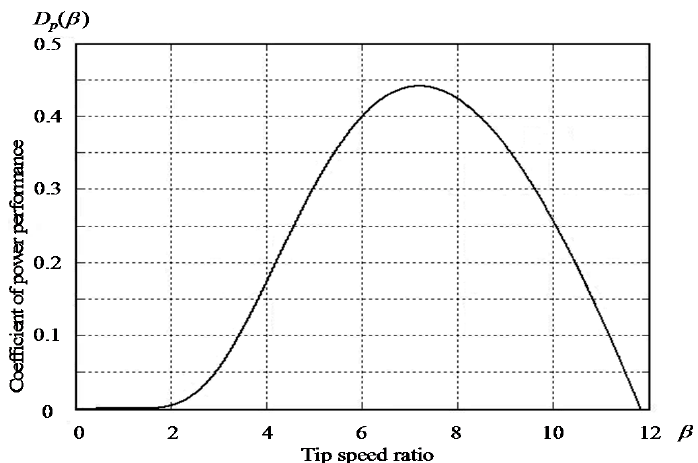
Figure 2. Characteristic curve of coefficient D p p β q of power performance versus tip ratio β for WT.